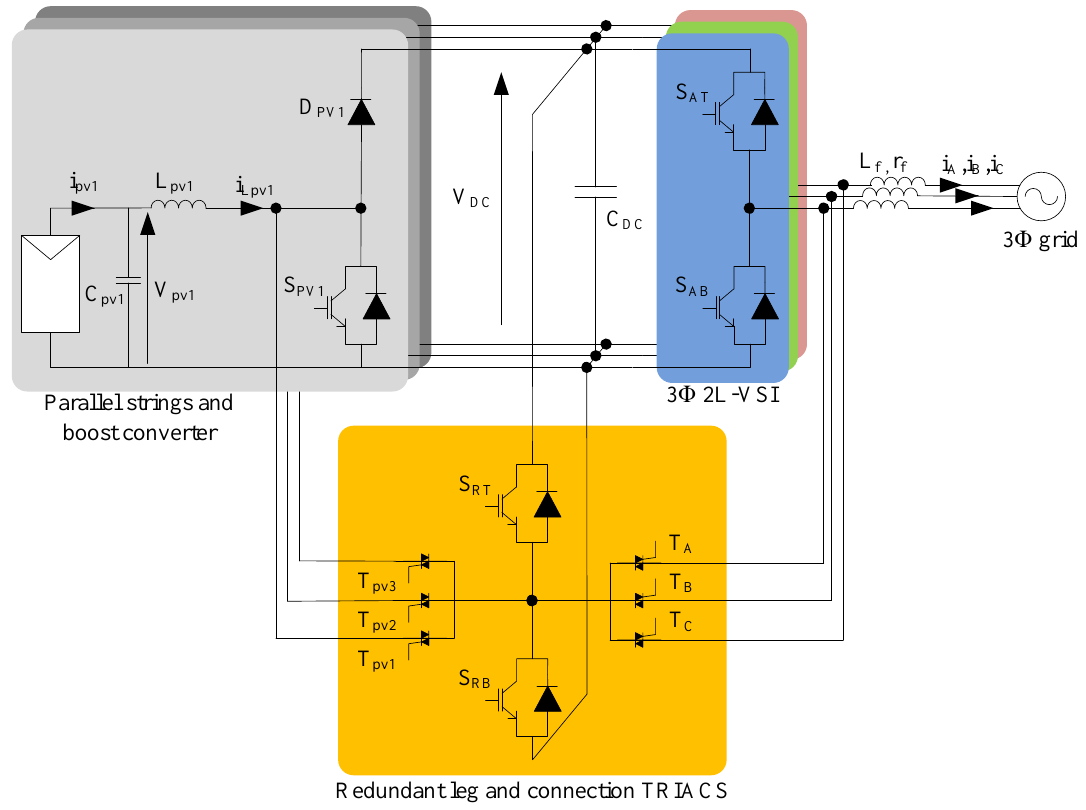
Figure 1. Proposed fault-tolerant photovoltaic (PV) multistring